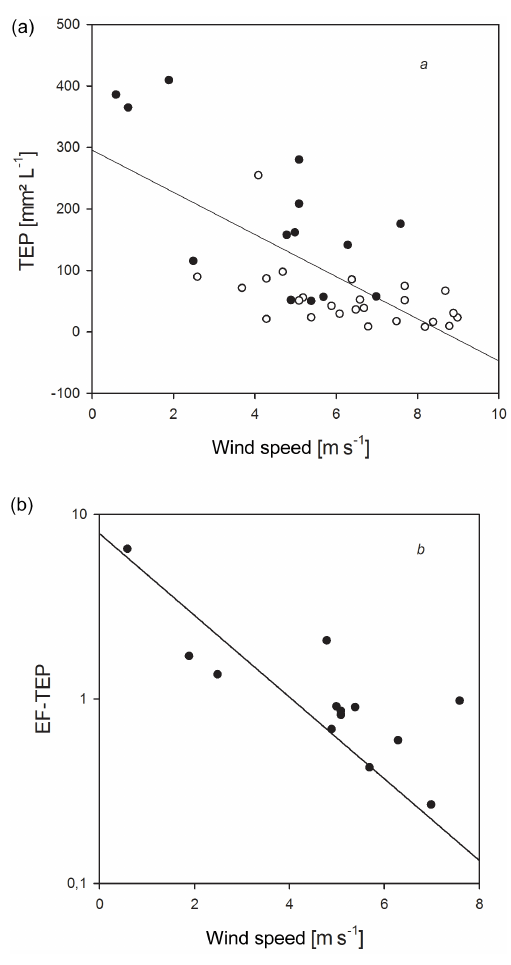
Figure 7. Influence of wind speed (ms − 1 ) on the total area con- centration of TEP (mm 2 L − 1 ) in the SML at all stations (a) and relationship between TEP enrichment factors (EFs) and wind speed (ms − 1 ) for only those stations that showed similar sea surface tem- perature as indicated in Fig. 3. Filled dots indicated data from sta- tions of similar sea surface temperature. Data in plot (b) were fitted by a power law